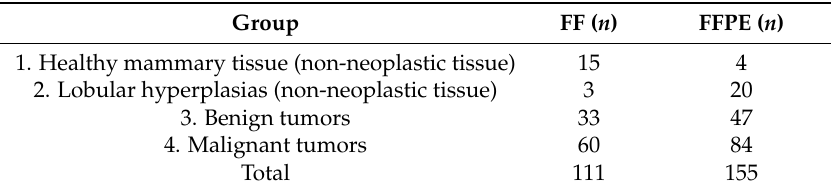
Table 1. Number of specimens of fresh frozen (FF) and formalin-fixed, paraffin-embedded (FFPE) per group.